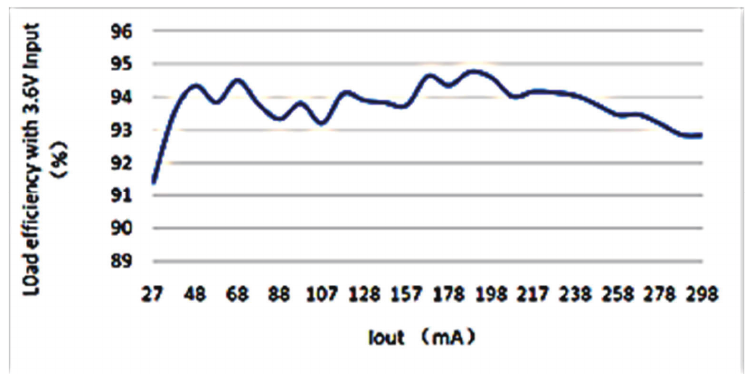
Figure 15. The efficiency of the proposed boost converter.